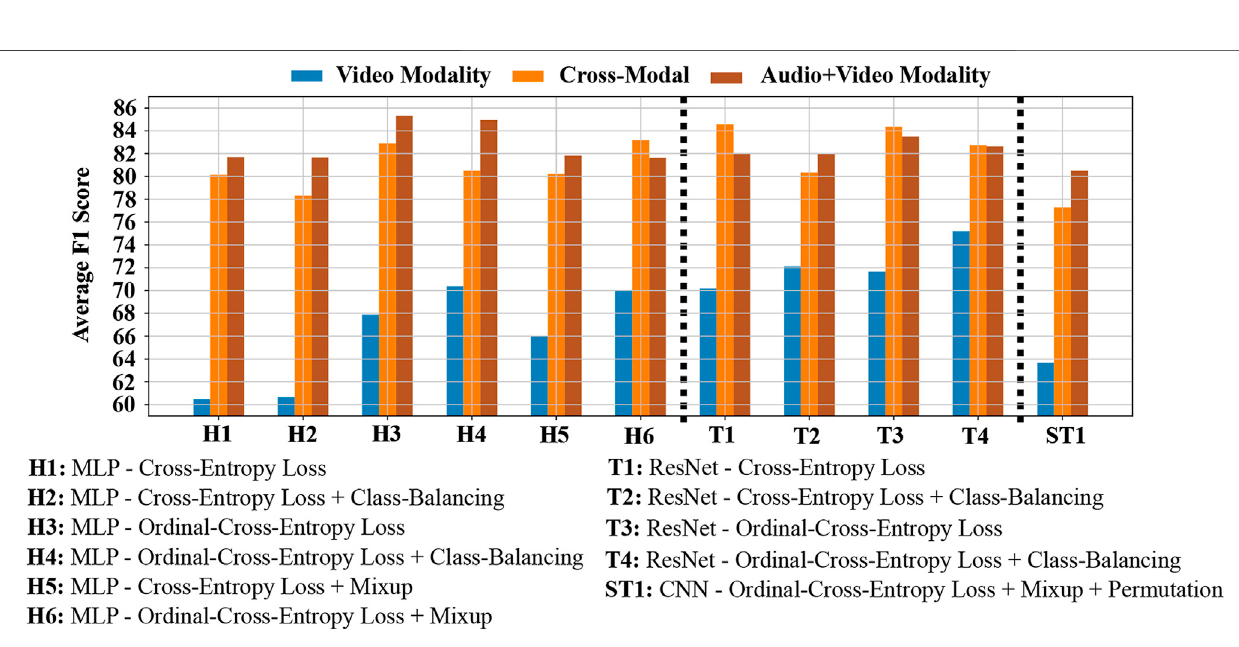
Frontiers in Computer Science |